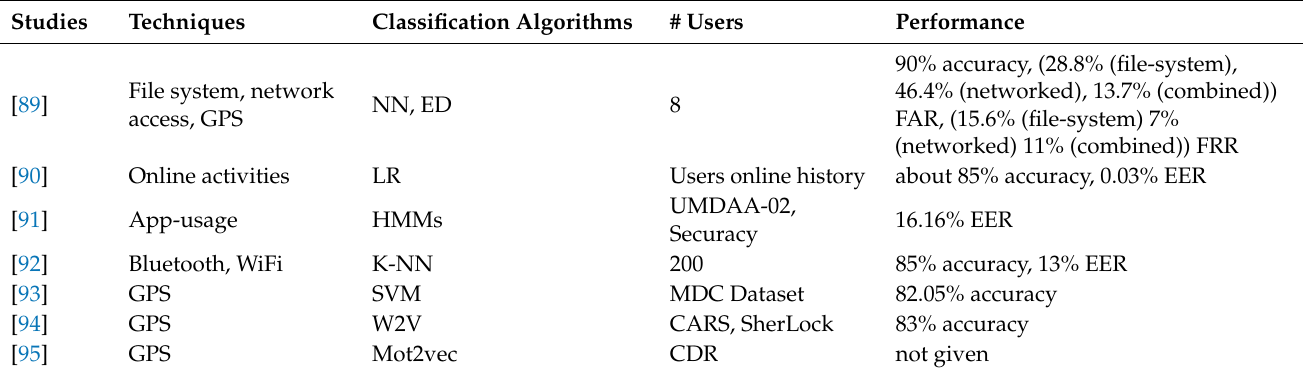
Table 9. Context-aware